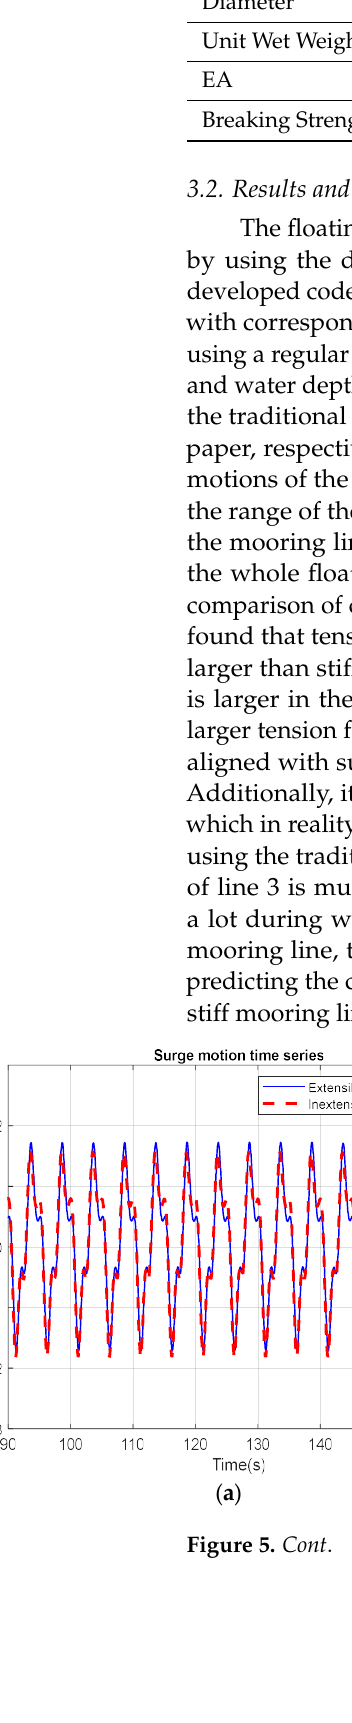
( d ) ( e ) Figure 5. Comparison of time series of surge and heave motion time series, mooring tension at the fairlead using traditional stiff line model and proposed tensile mooring line model, ( a ) Surge ( b ) Heave ( c ) Line 1 ( d ) Line 2 ( e ) Line 3.